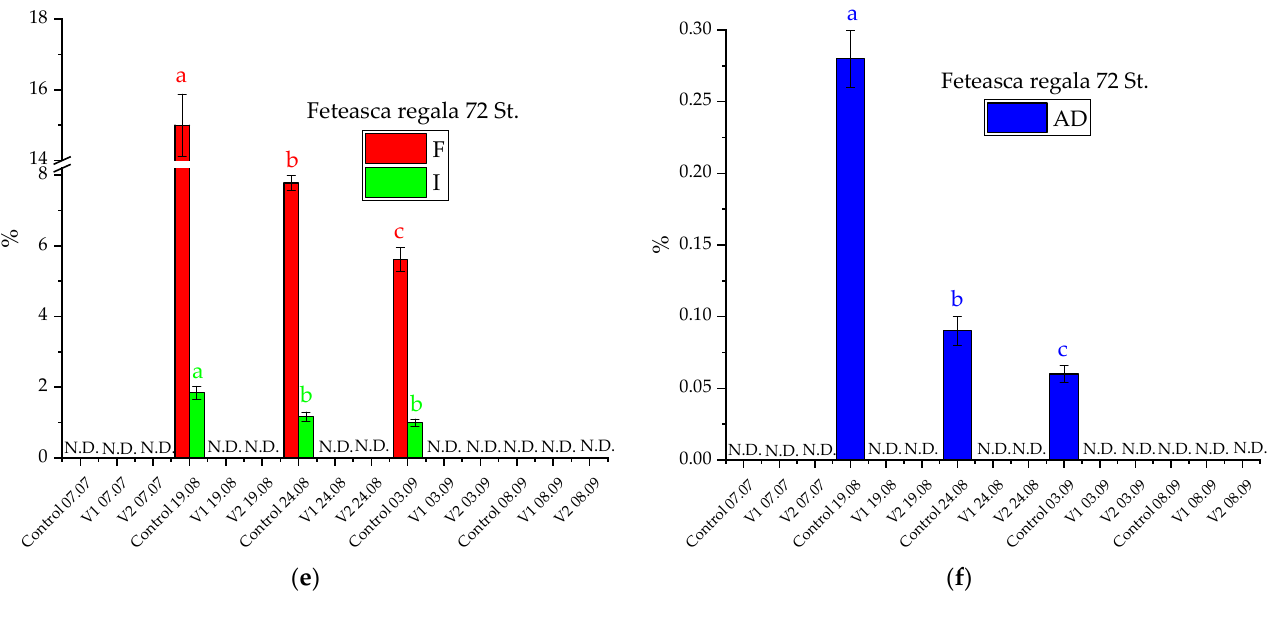
Figure 5. Frequency (F), intensity (I), and attack degree (AD) evolution of U. necator during successive treatments in 2020 on the studied clones: ( a , b ): Feteasca alba 97 St; ( c , d ): Feteasca neagra 6 St; ( e , f ): Feteasca regala 72 St. The values represent means ± SD. Means of the same parameter (same color) without a common lowercase letter (a to g) differ ( p < 0.05) as analyzed by one-way ANOVA and the TUKEY test; V1 = alcoholic extract of D. filix-mas , V2 = alcoholic extract of D. filix-mas with silver nanoparticles, C—control (chemical pesticide); for the Cabernet Sauvignon 131 St. clone, all the registered results were null; N.D.—not detected (no pathogen attack registered).